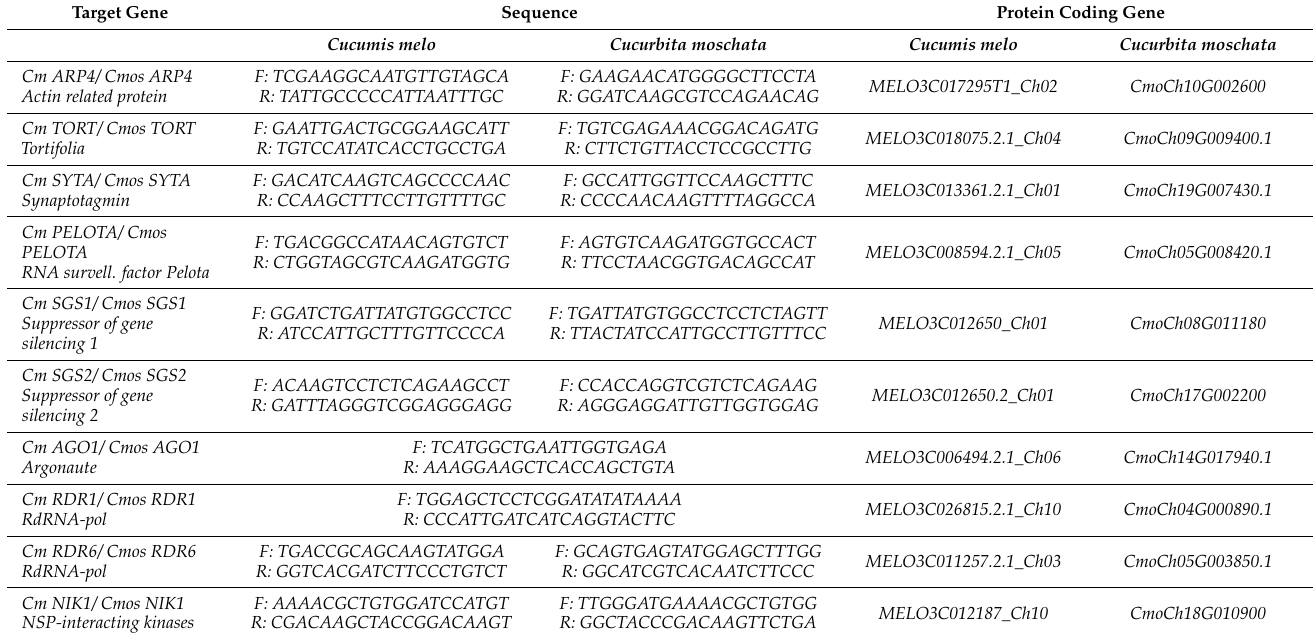
Table 1. Primer sequences used in RT-PCR for amplifying candidate genes in C melo and C. moschata . Target Gene Sequence Protein Coding